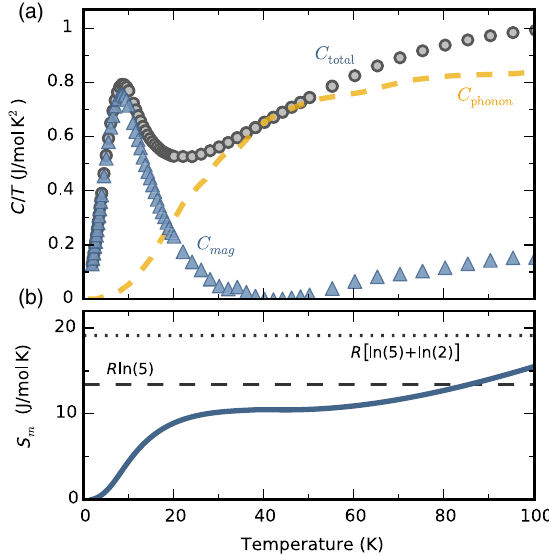
FIG. 2. Magnetic susceptibility of FeSc 2 S 4 . The low- temper- ature susceptibility is shown in the main panel. A temperature - independent contribution of χ 0 ¼ 0 . 03 emu = mol resulting from ≤ 0 . 05% residual FeS has been subtracted. Open circles are the susceptibility measured on our sample, dashed line is bulk susceptibility data from Fritsch et al. [14], and triangles show the NMR Knight shift data from Ref. [15]. Inset: Inverse susceptibility, where the solid line is a linear fit to a Curie-Weiss law.